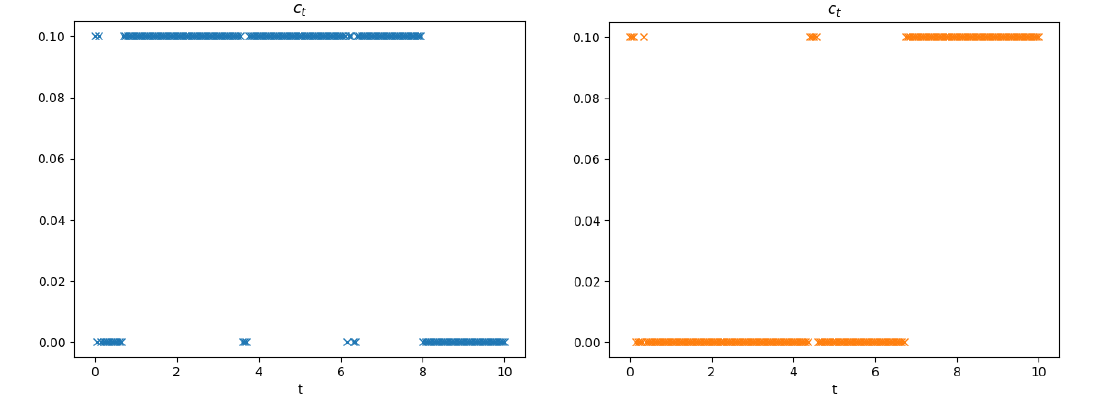
Figure 4. The corresponding payout strategy c t for the paths of the surplus process in Figure